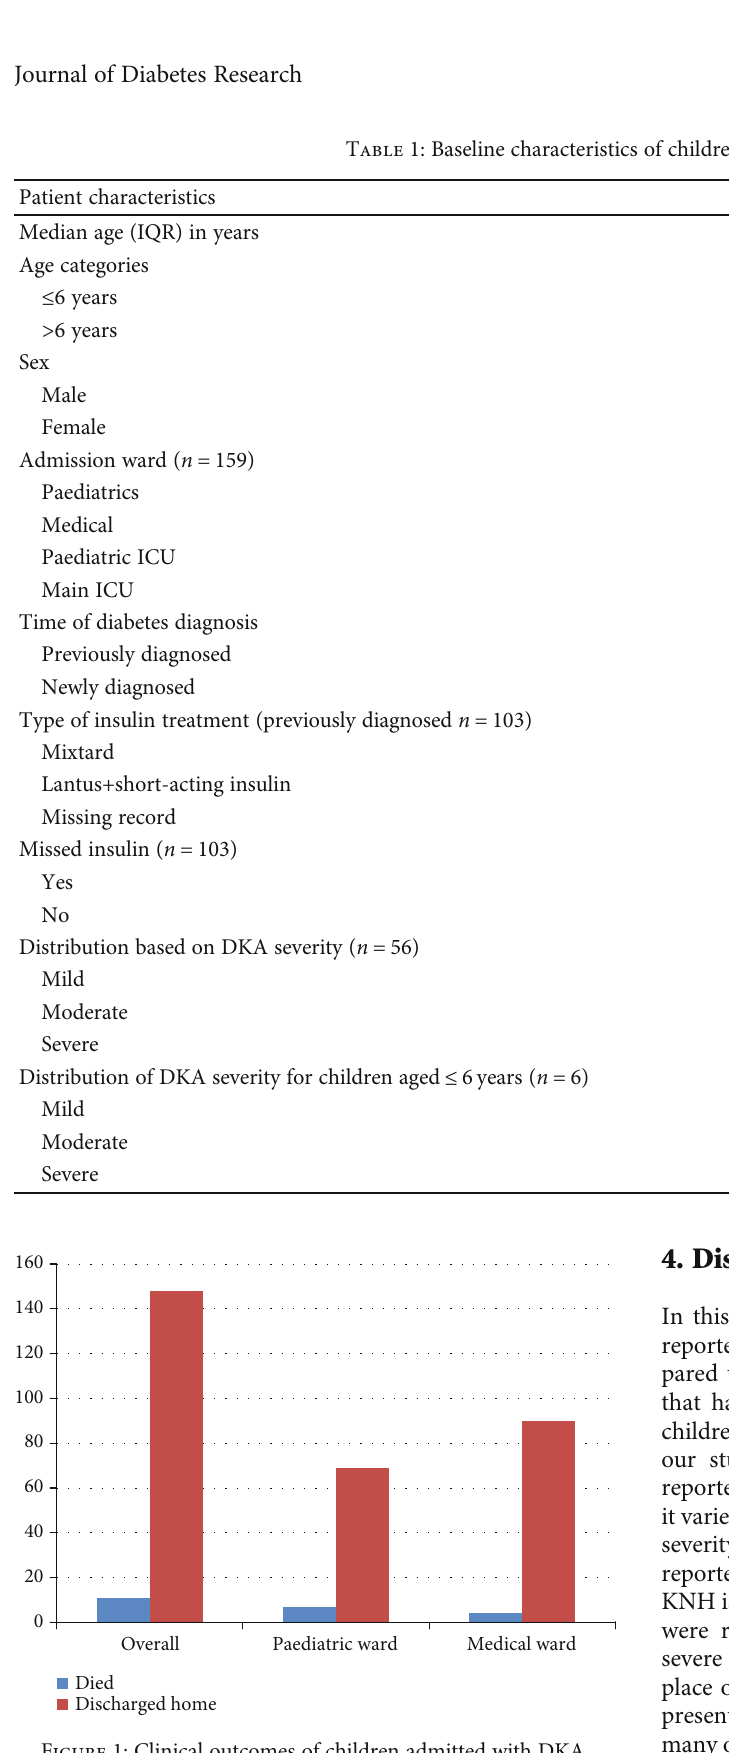
Figure 1: Clinical outcomes of children admitted with